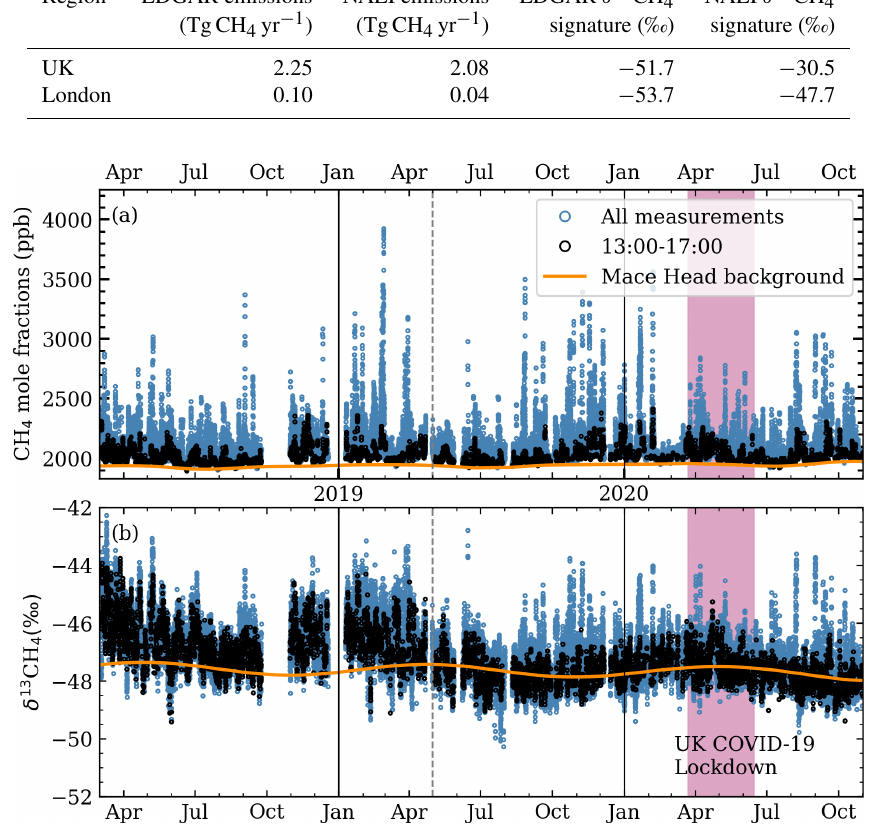
Figure 4. The 20min averaged measured (a) mole fractions and (b) δ 13 CH 4 values at ICL, along with the daily Mace Head background values from March 2018 to October 2020. Afternoon (13:00–17:00) data are shown in black. The period of the first UK national COVID-19 lockdown is denoted by the pink region. The dashed grey line denotes when the standard and target tanks were changed.